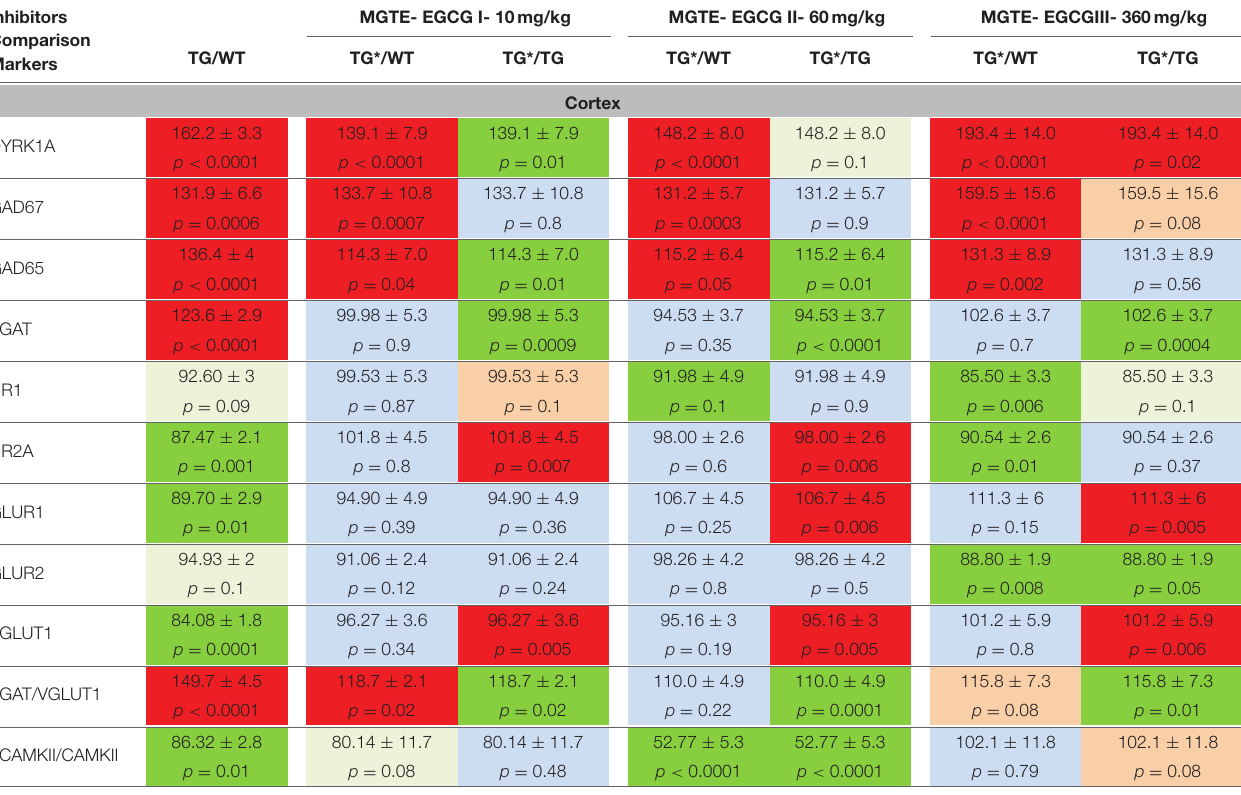
TABLE 3 | Protein levels of markers of inhibition and excitation pathways for WT and mBACtgDyrk1a (Tg) in cortex following treatment with 3 doses of MGTE extract. Inhibitors Comparison